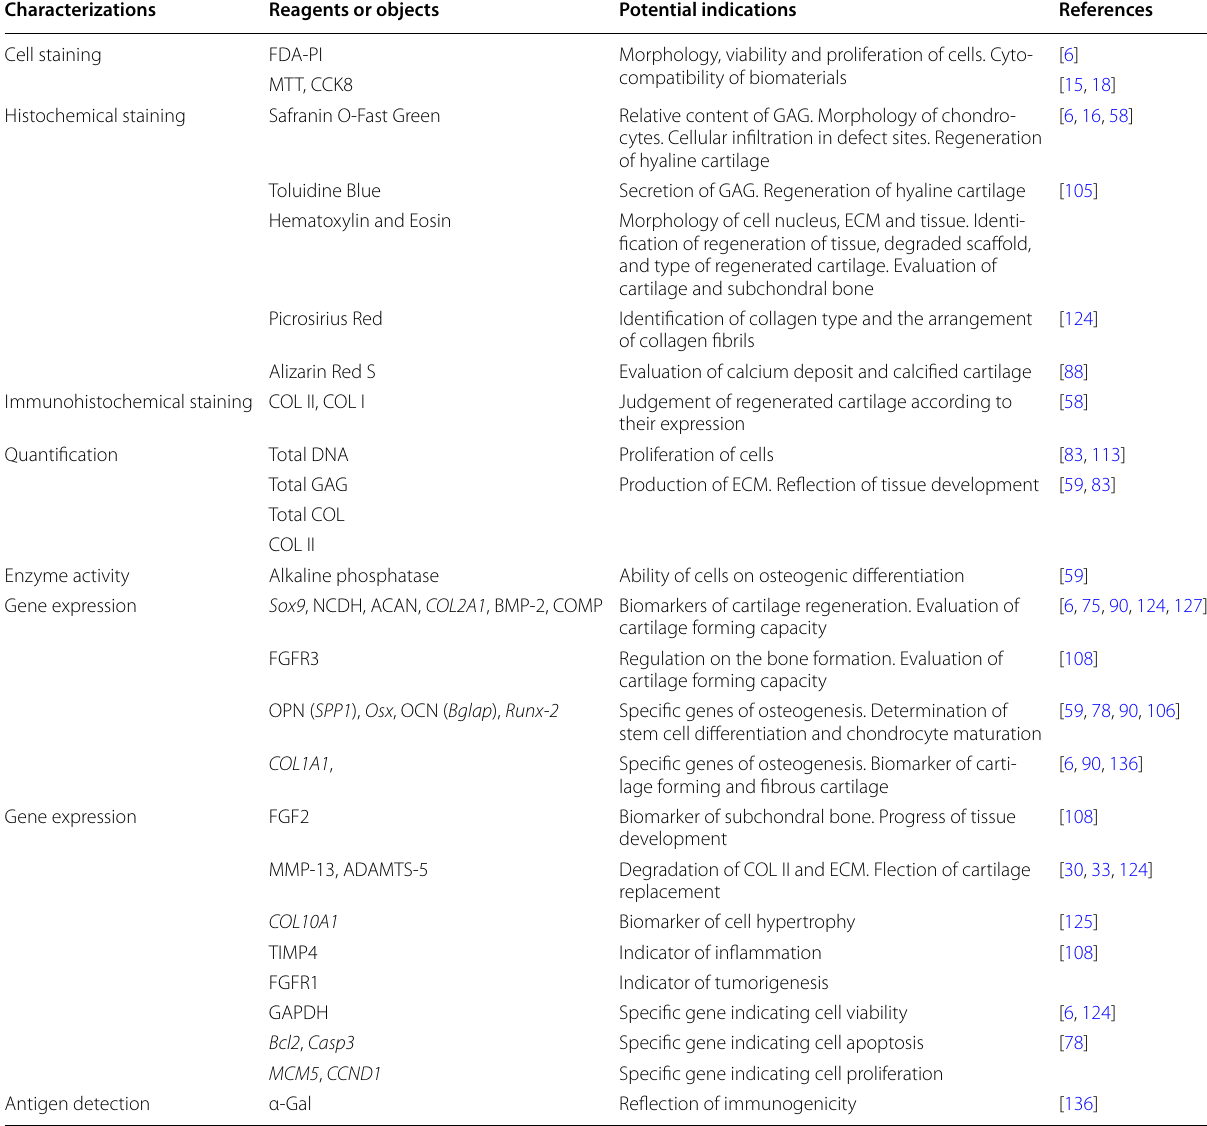
Table 1 General methods used to evaluate the bioactivities of biomaterials